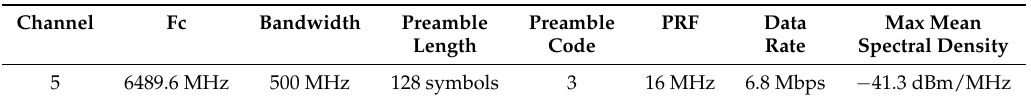
Table 2. UWB system configuration.